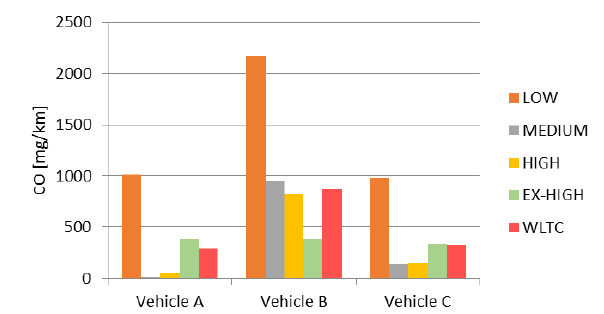
Fig. 8. Carbon monoxide emissions in WLTC test and its particular stages